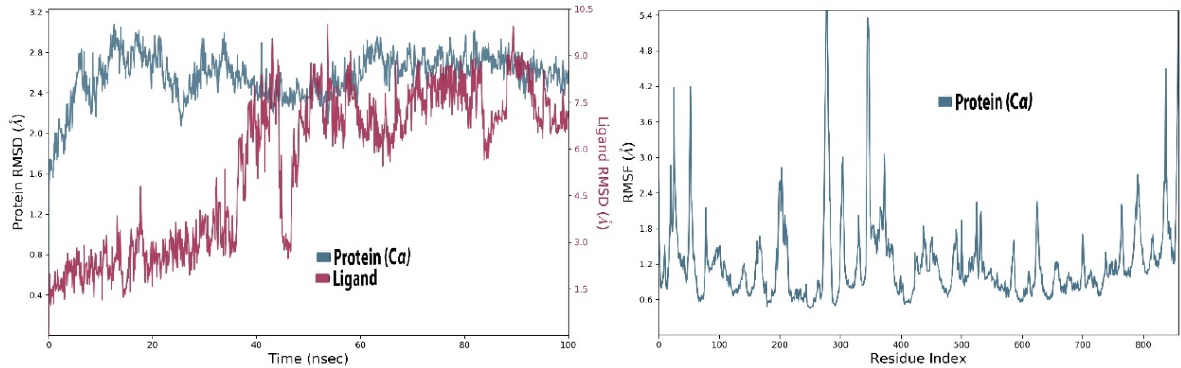
Figure 4. The left panel shows the RMSD of C-alpha of amino acid residues of RdRp (blue) or myricetin (maroon) during 100 ns of simulation time. The right panel shows fluctuation in the amino acid residues of RdRp in complex with myricetin.